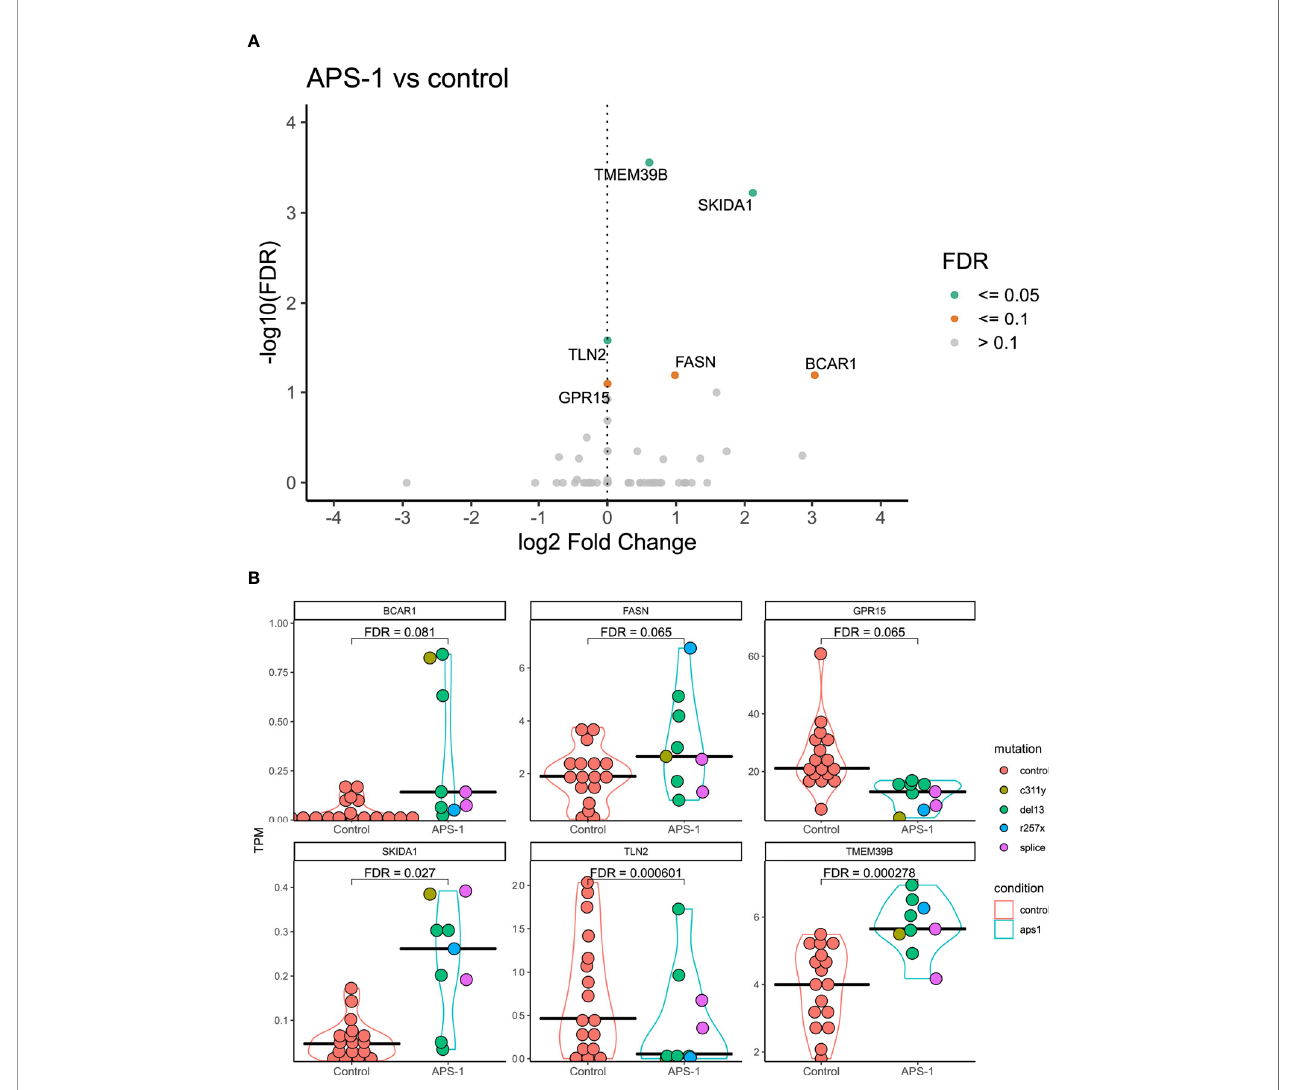
FIGURE 3 | Differential expression analysis of regulatory T cells from APS-1 patients and healthy subjects. (A) . Volcano plot of the most signi fi cantly differentially expressed genes with the magnitude of differential expression in log2 fold change and the signi fi cance level in -log10 FDR. (B) Violin plots showing the absolute expression level in transcripts per million (TPM) in all samples for the genes identi fi ed as signi fi cantly differentially expressed at a 10% FDR level in (A) . FDR values on violin plots taken from differential expression analysis using DESeq2 (v. 1.30.1)in R (v.